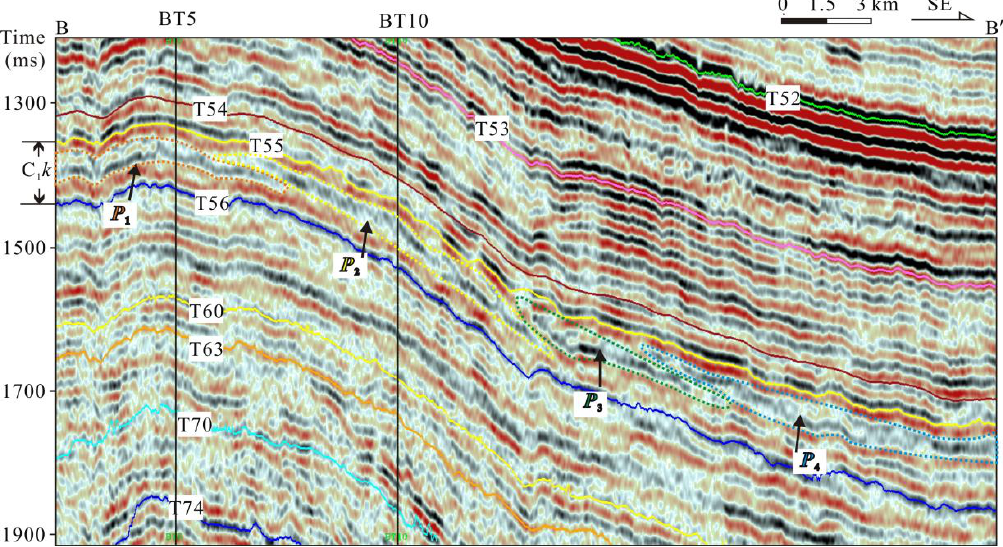
Figure 9. Seismic section across wells BT5 and BT10 in SE direction of the delta progradational reflection of the Karashayi Formation. See Figure 1b for section position, P 1 means progradation I, P 2 means progradation II, P 3 means progradation III, and P 4 means progradation IV. Karashayi Formation is located between T55–T56 seismic reflection boundaries. See Figure 1b for the location.